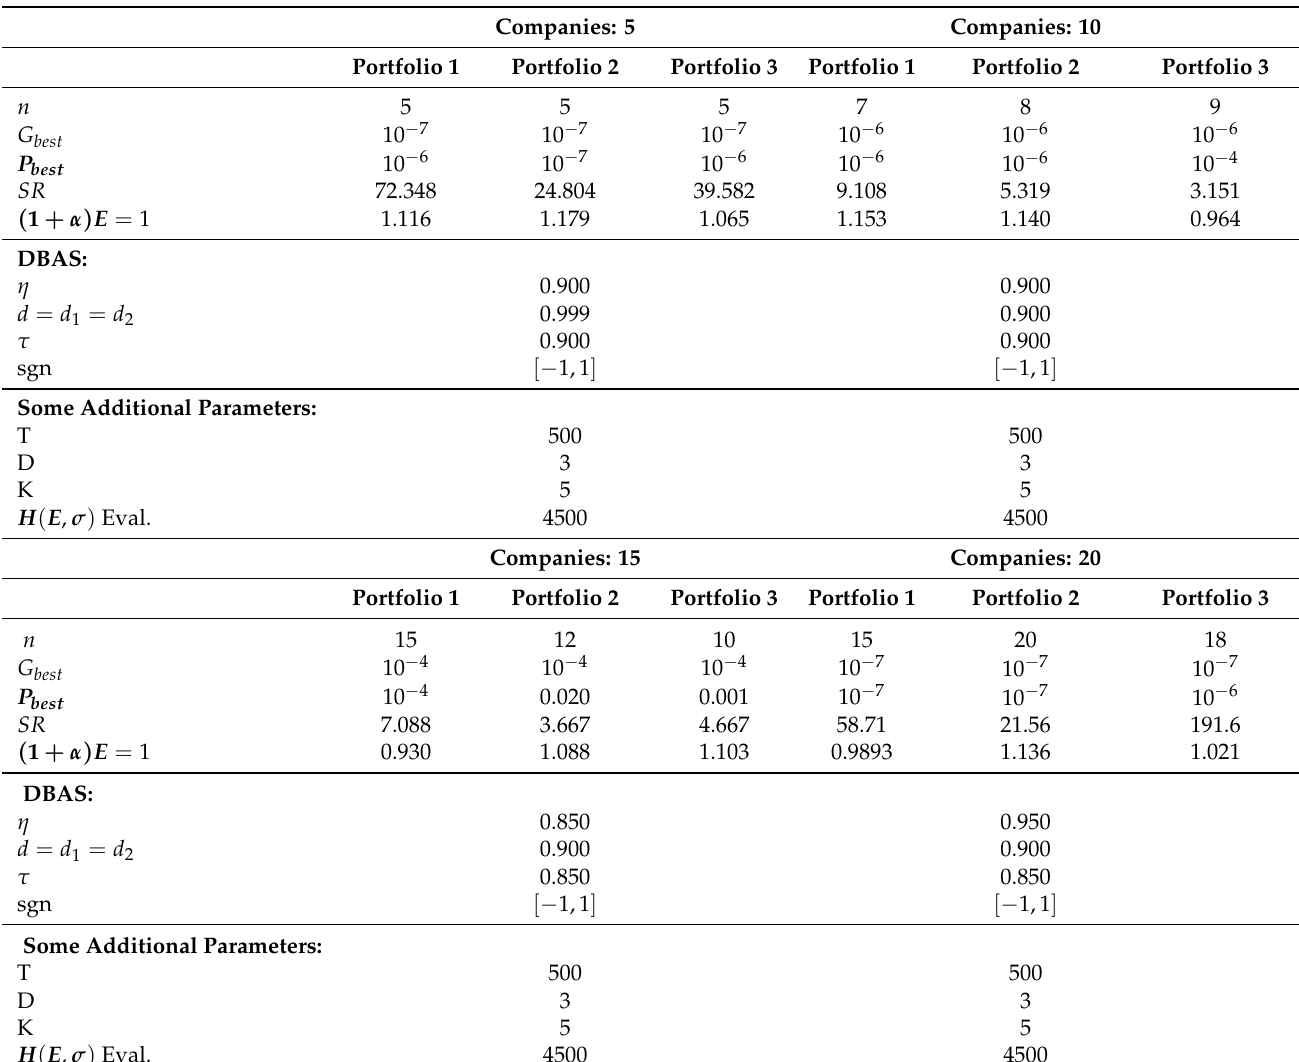
Table 3. DBAS Convergence Profile for Different